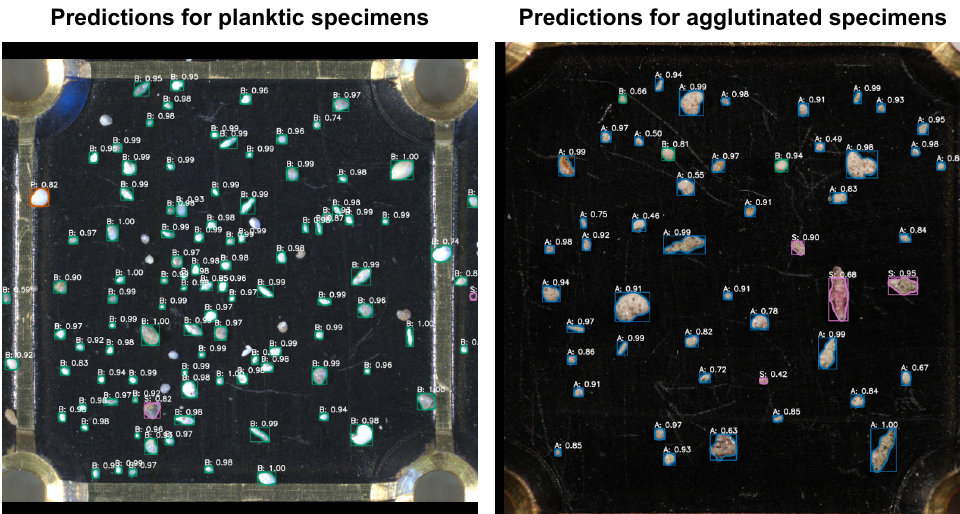
Figure 12. Additional examples of predictions for two images from the test dataset. ( Left ): Predictions for purely planktic specimens. There are a few false positives, but the accuracy and quality of true positive detections are good. Note that some objects that have been misclassified. ( Right ): Predictions for purely agglutinated benthic specimens. Good accuracy and quality of predicted masks and bounding boxes the majority of detections. However, low quality masks and misclassified detections are